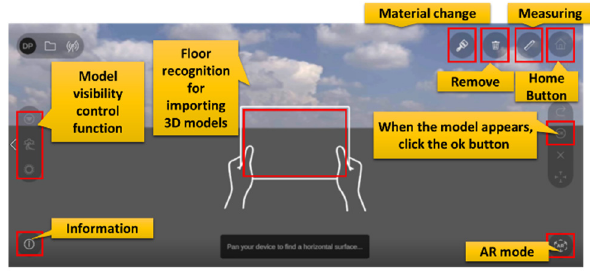
Figure 17. Mobile app interface.